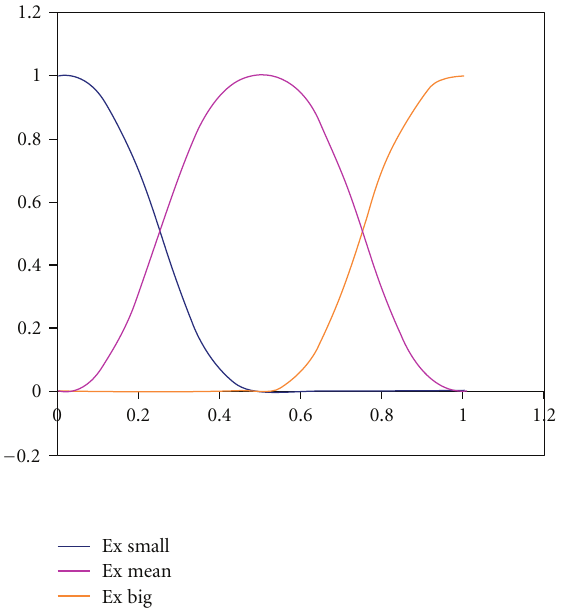
Figure 8: “Ex small,” “Ex medium,” and “Ex big” ( a = 0 . 03, b = 0 . 5, c = 0 .